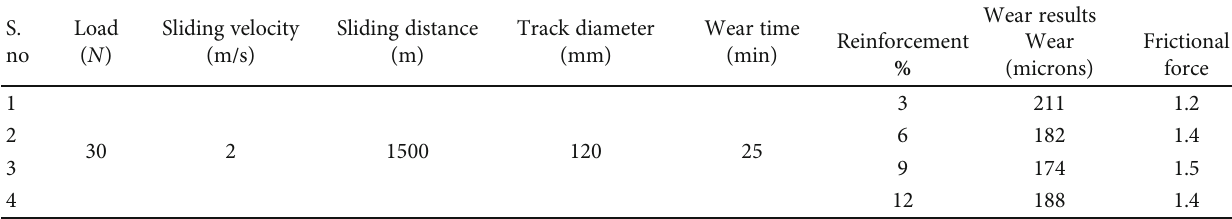
Figure 13: Cutting speed vs. cutting force (depth of cut 1.6mm). Table 8: Summary of wear